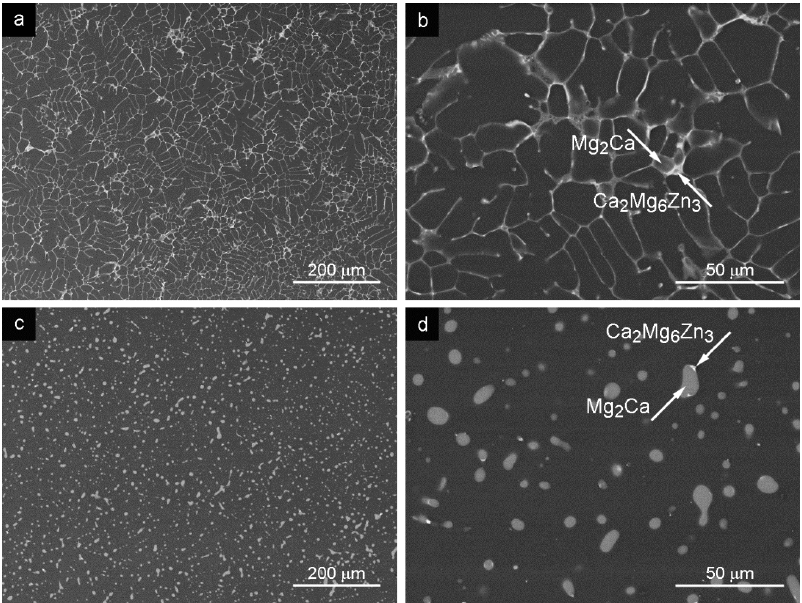
Figure 2. Microstructure of SCL sample: ( a ) SCL state; ( b ) secondary phases in the SCL state; ( c ) SCL + HT; ( d ) secondary phases in SCL + HT depicted in the SEM–BSE mode.